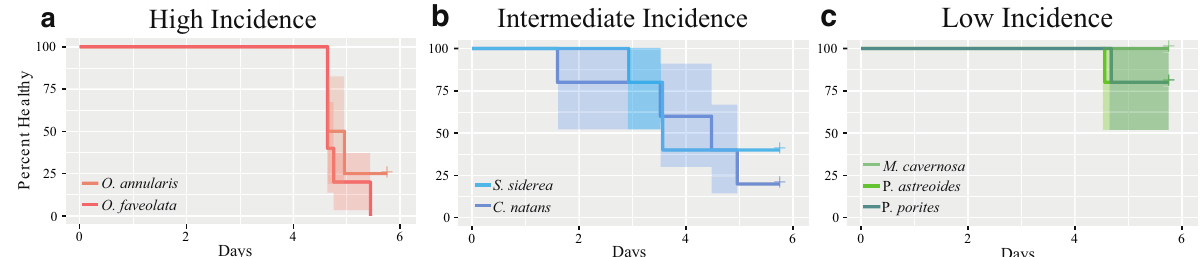
Fig. 3 Disease incidence. Survival curves showing the proportion of corals that remained healthy (i.e., did not develop lesions) over the course of the experiment for species that showed high ( a ), intermediate ( b ), and low ( c ) incidence of disease. Shading around survival curves represents 95% con fi dence intervals.